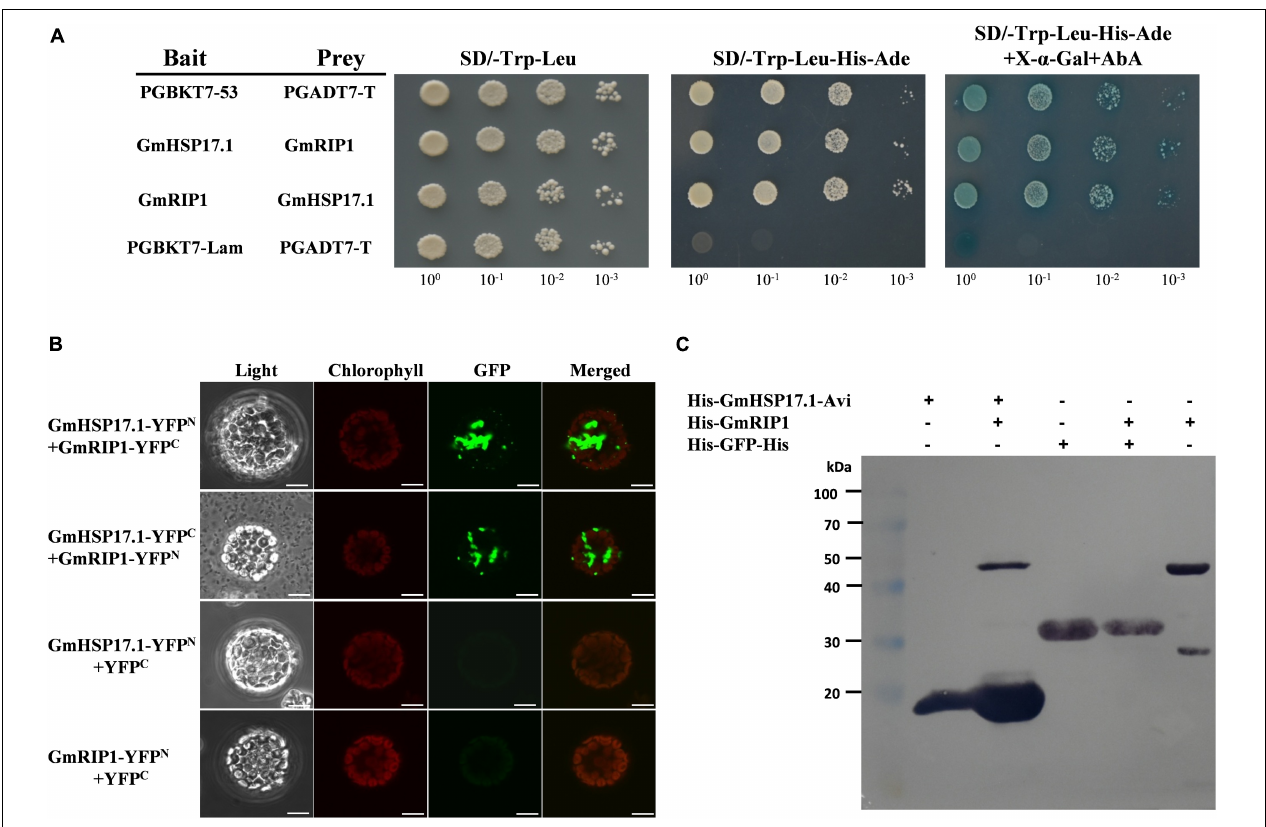
FIGURE 6 | GmHSP17.1 interacts with GmRIP1. (A) Interaction between GmHSP17.1 and GmRIP1 in yeast. Positive yeast strains were selected on SD/-Trp-Leu medium and further verified on SD/-Tru-Leu-His-Ade medium containing 125 ng/ml AbA and 40 µ g/ml X- α -Gal. (B) bimolecular fluorescence complementation (BiFC) analysis of interaction between GmHSP17.1 and GmRIP1 in Arabidopsis protoplasts. Fluorescence signal could only be found in the cytoplasm of Arabidopsis protoplasts transformed with GmHSP17.1-YFP N and GmRIP1-YFP C or GmHSP17.1-YFP C and GmRIP1-YFP N , while there was no fluorescence signal in protoplasts with GmHSP17.1-YFP N or GmRIP1-YFP N co-expressed with empty vector YFP C . Scale bars = 10 µ m. (C) Interaction between GmHSP17.1 and GmRIP1 in vitro by pull-down assay. Pull-down assay was performed using recombinant His-GmHSP17.1-Avi protein purified by streptavidin agarose resin and the total cell lysates of His-GmRIP1 and the western blot with anti-His